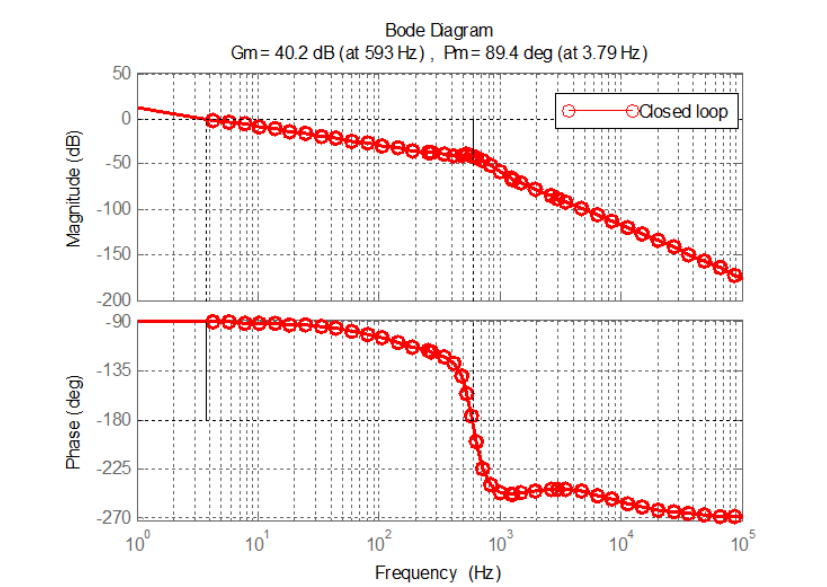
Figure 11. Close loop system bode